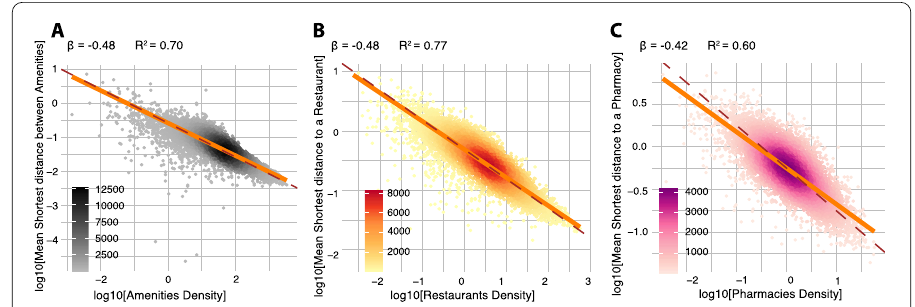
Figure 3 Scalingofmeanshortestdistancebetweenamenitiesanddensityofamenities . The orange line shows the best fit line while the dashed red line represents the –0.5 slope line. ( A ) Scaling of mean shortest distances and densities of all amenities. ( B ) Scaling of mean shortest distances between all amenities to restaurants and densities of restaurants. ( C ) Scaling of mean shortest distances between all amenities to pharmacies and densities of